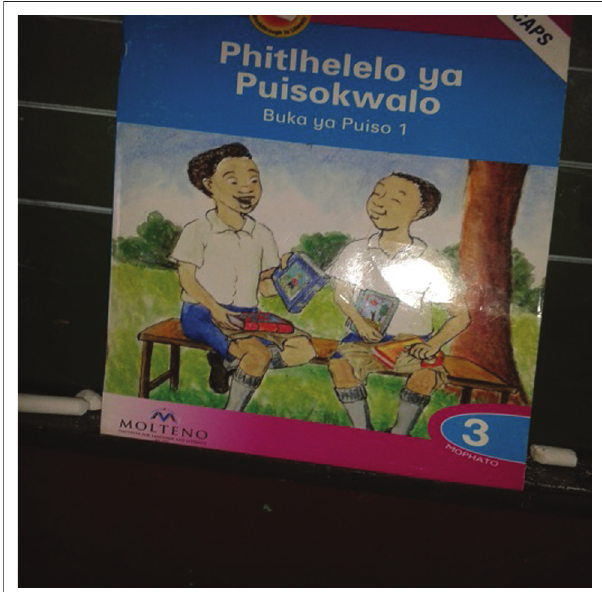
FIGURE 2: Phitlhelelo ya Puisokwalo (Pooe